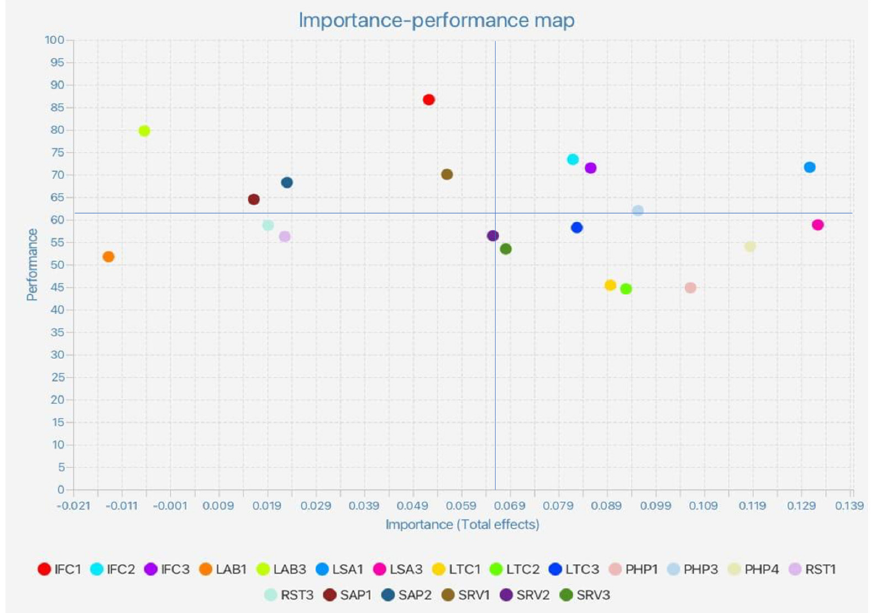
Figure 3. Importance-performance map of indicators.